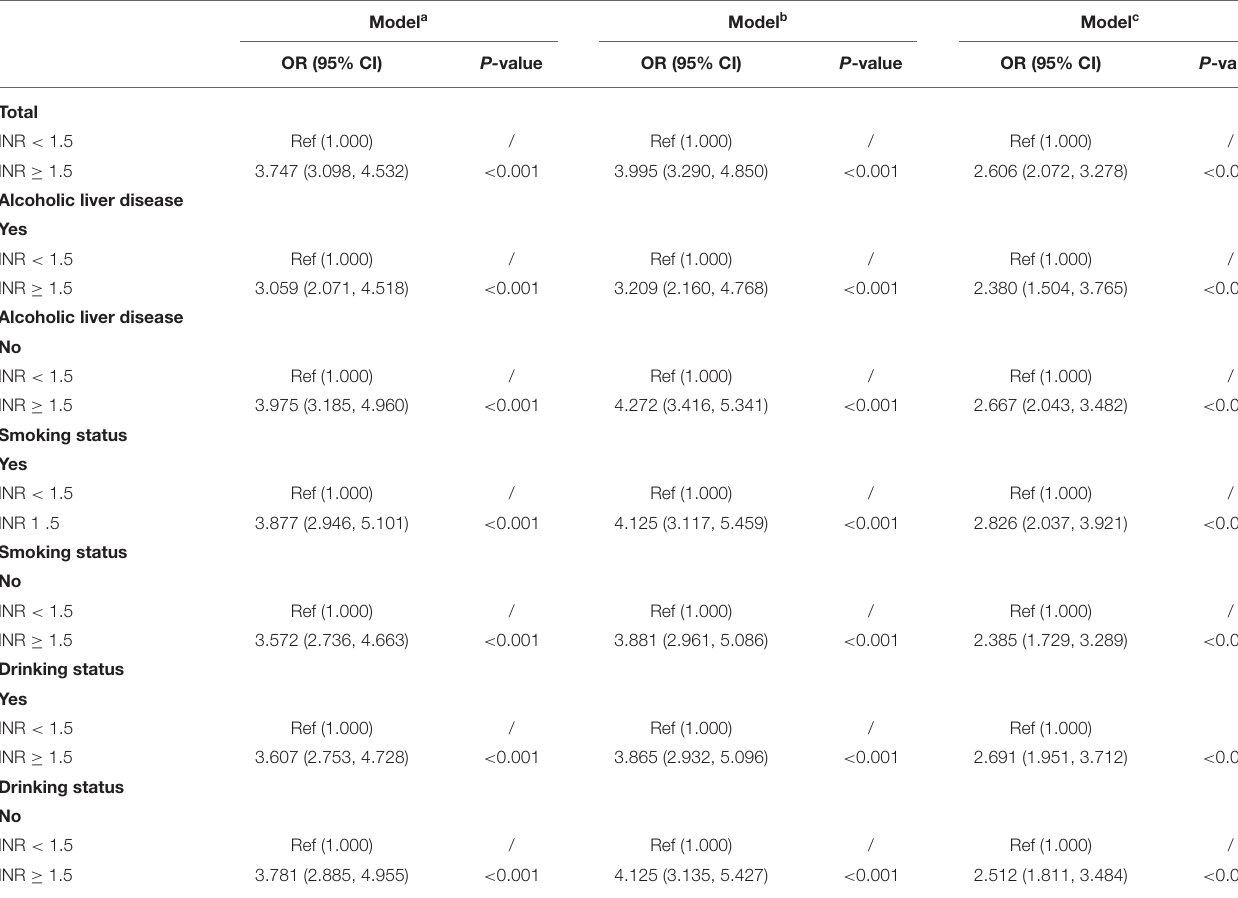
TABLE 2 | Logistic regression analysis of the association between the INR and HE. Model a Model b Model